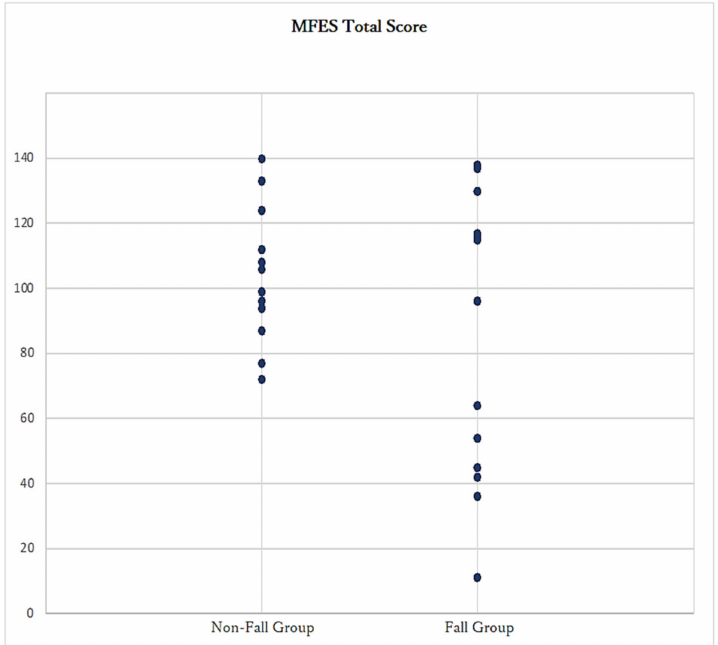
Figure 2. Distribution of the modified fall efficacy scale (MFES) scores for the fall and non-fall